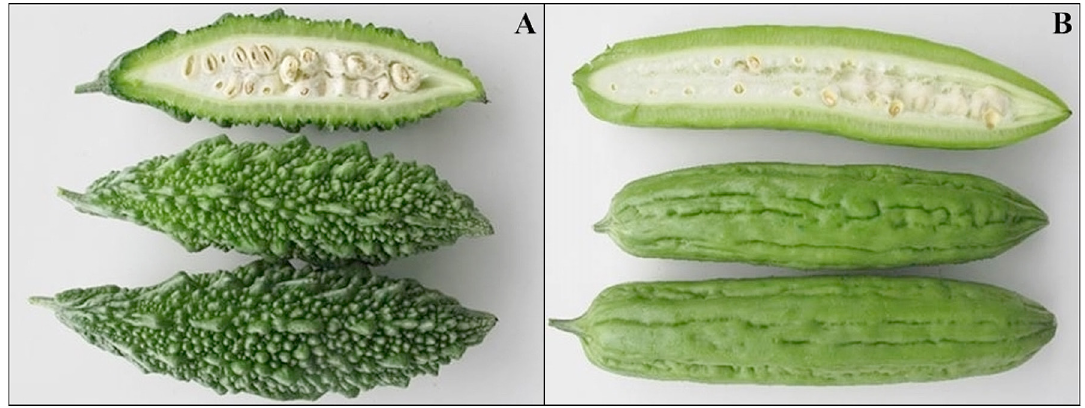
Fig. 1: South Asian (AVBG1301, A) and Southeast Asian (AVBG1313, B) bitter gourd market type